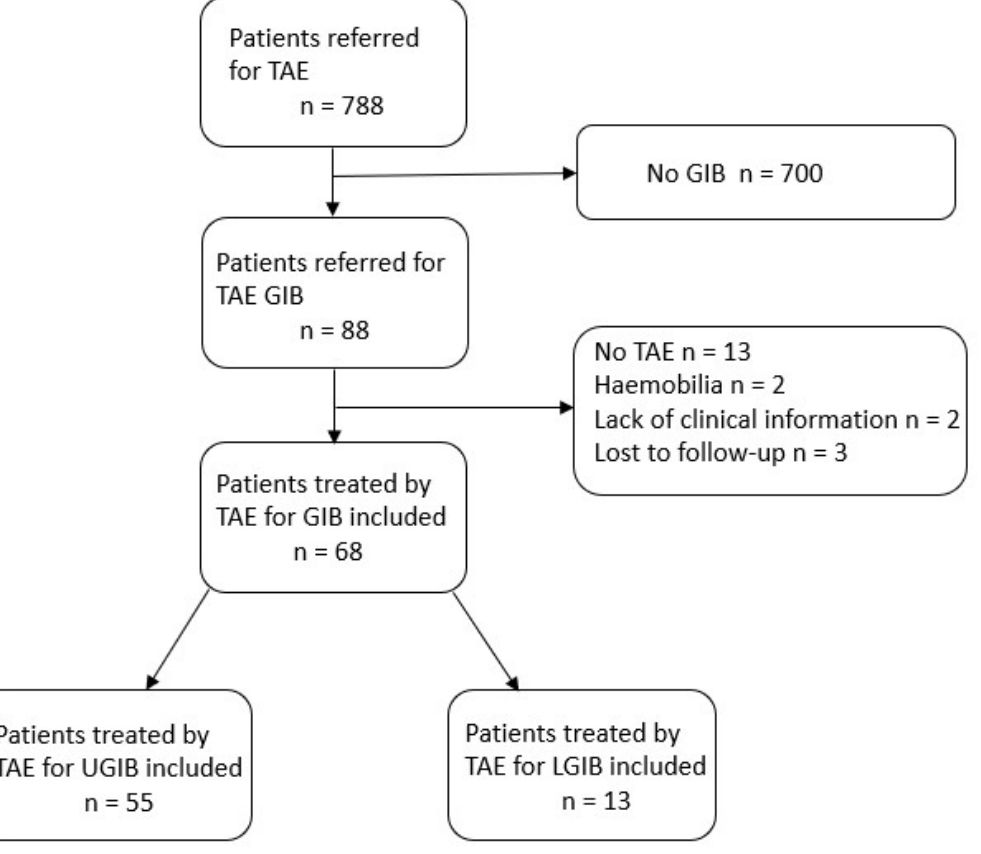
Figure 1. Flow chart of the study population.